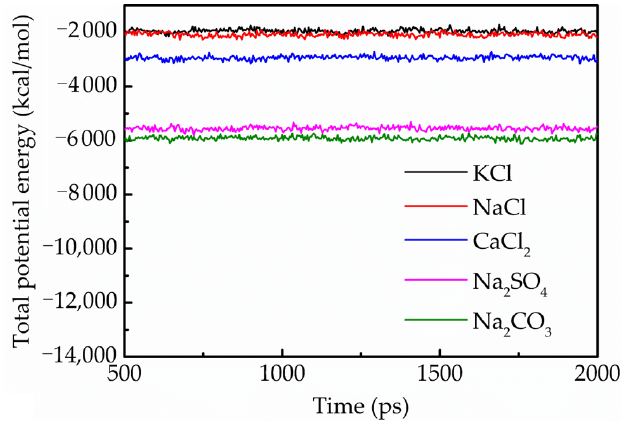
Figure 6. Potential energy in different inorganic salt systems.